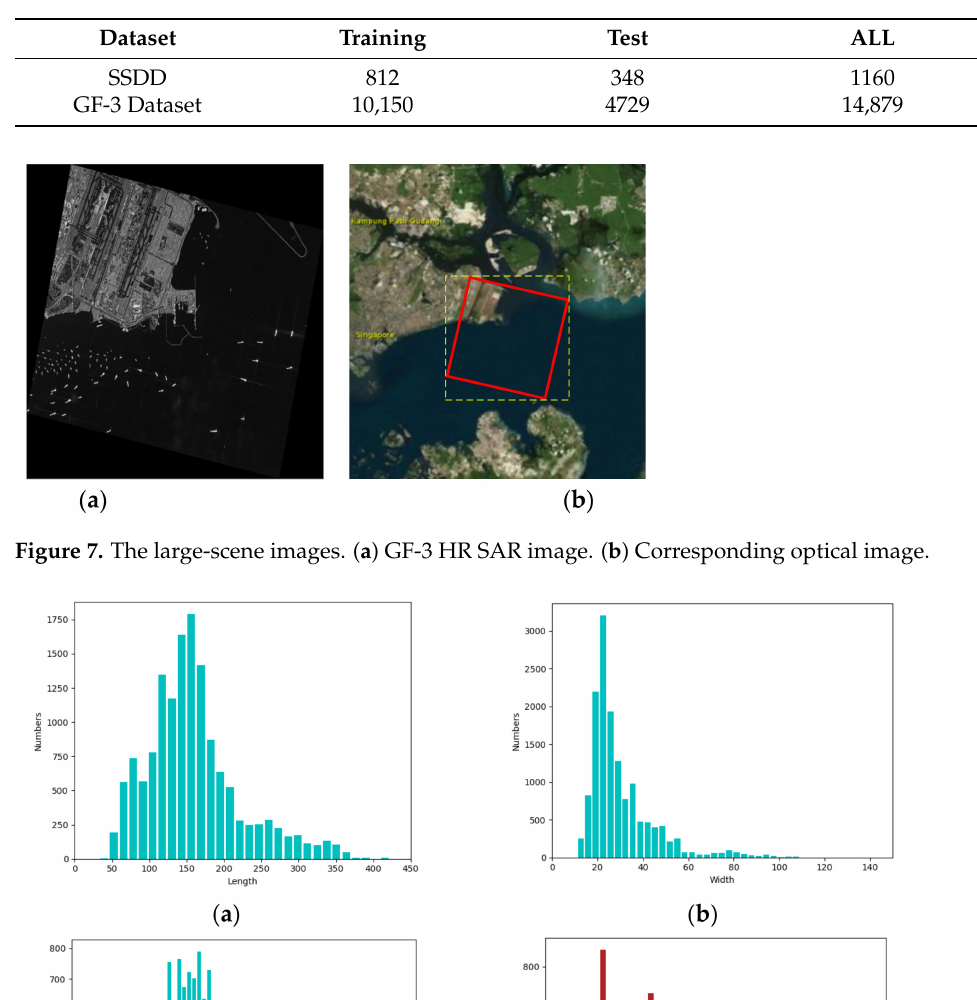
Table 3. Division of different datasets.